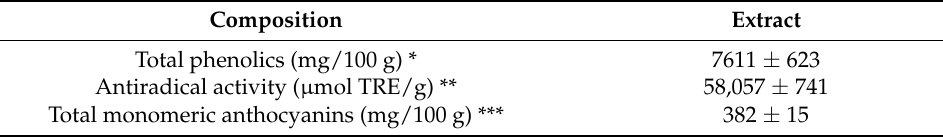
Table 2. Photometric analysis of Cornelian cherry extract. Composition